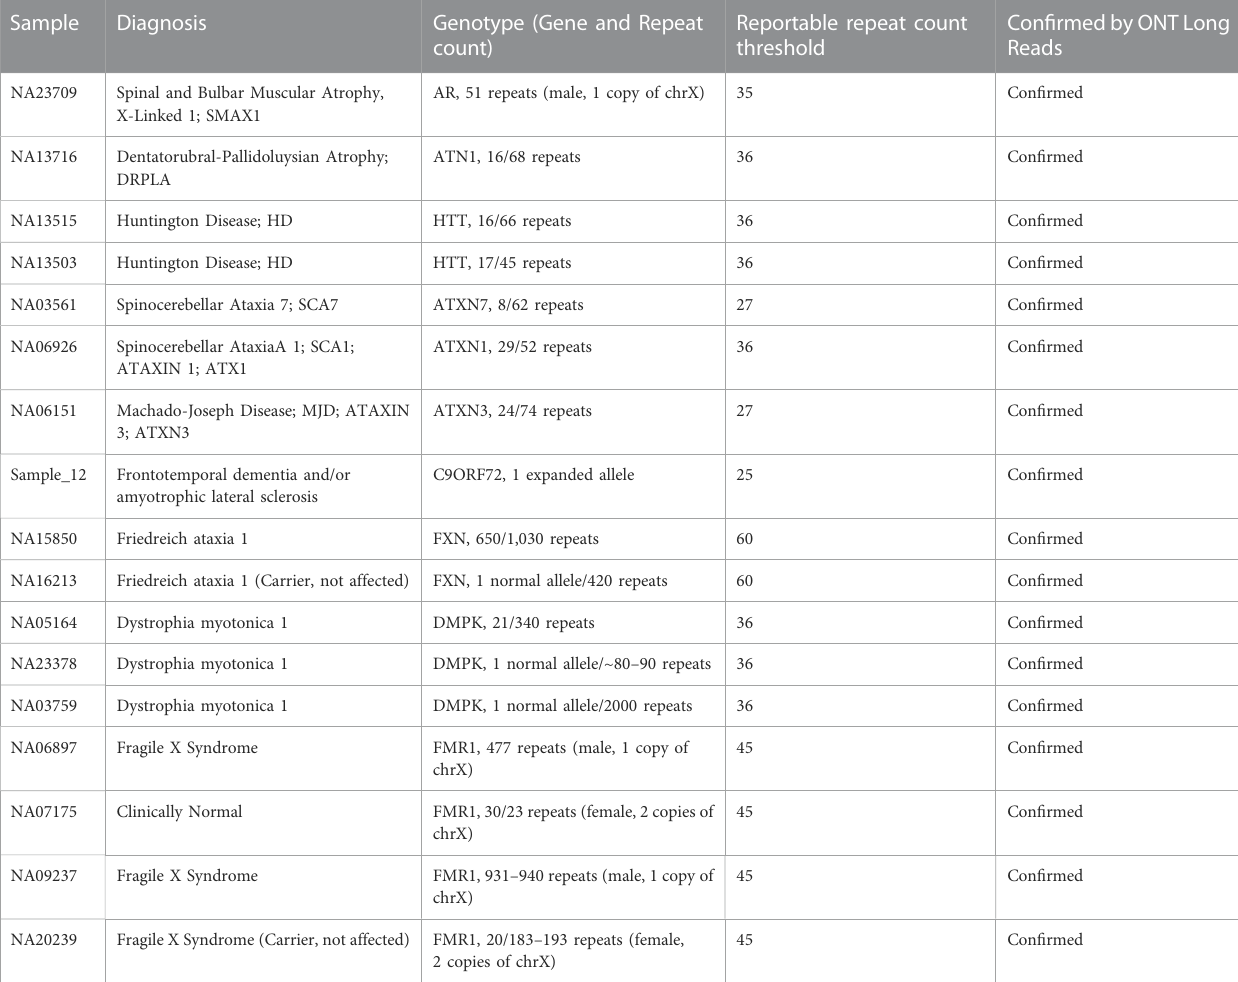
TABLE 5 Clinical validation of Short Tandem Repeats (STR) detection with long read sequencing.